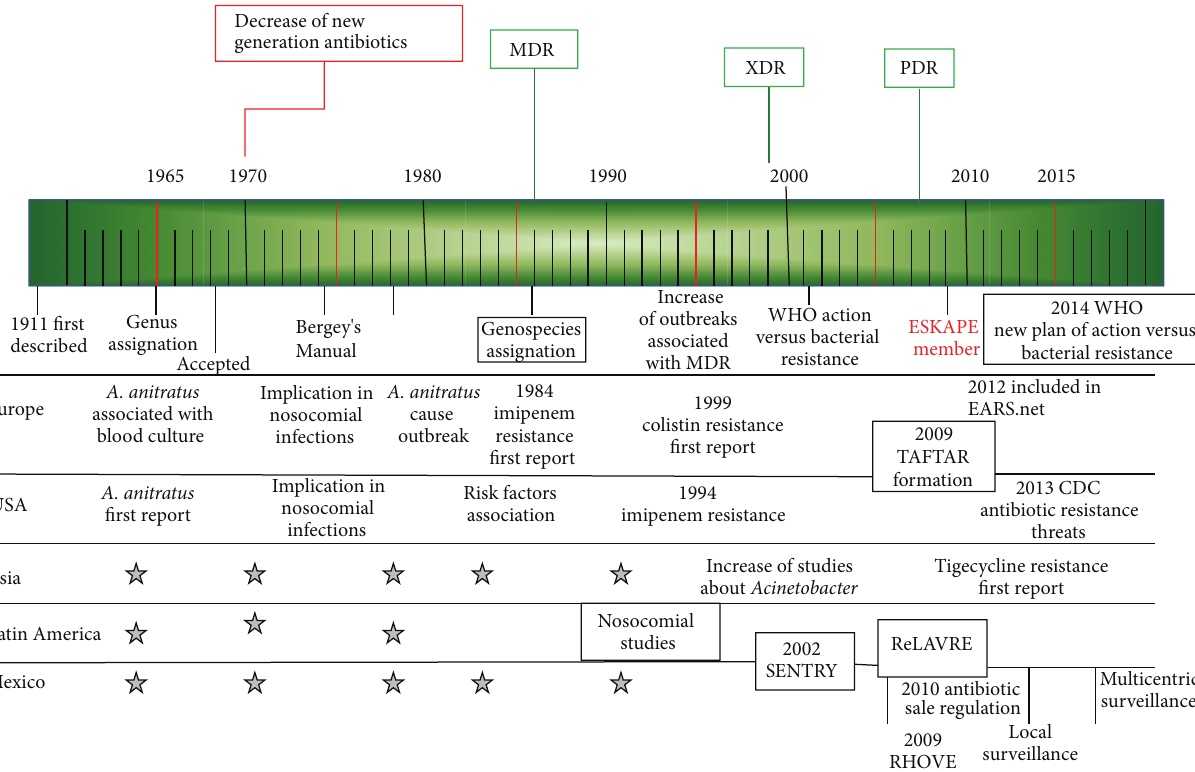
Figure 2: Brief history of the incorporation of Acinetobacter baumannii as one of the successful multidrug-resistant nosocomial pathogens. Thishasledtothestrategicallianceofdifferentcountriesandcontinentsinmonitoringresistantbacteria,andithasresultedintheformulation of a new action plan against bacterial resistance in